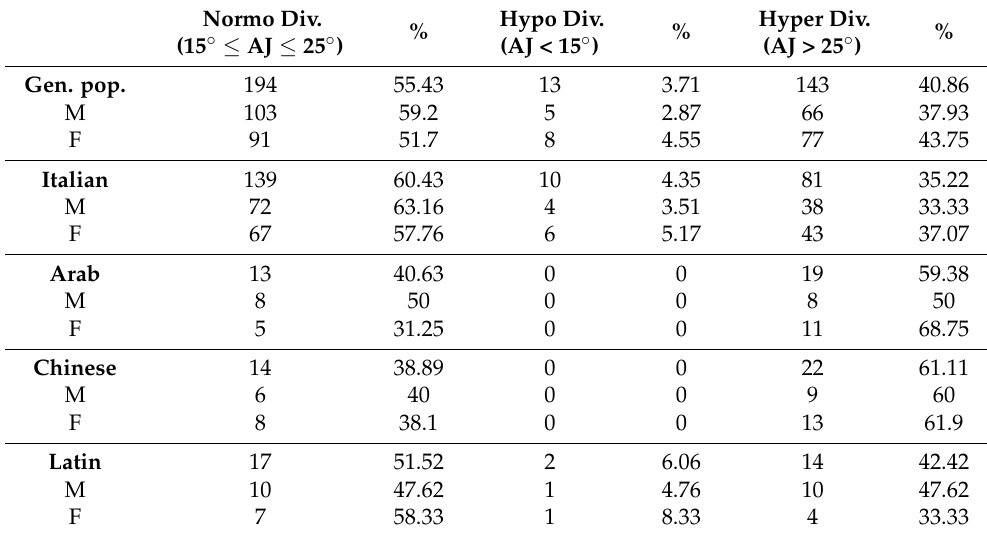
Table 3. Distribution of divergence in the selected patient sample. Normo